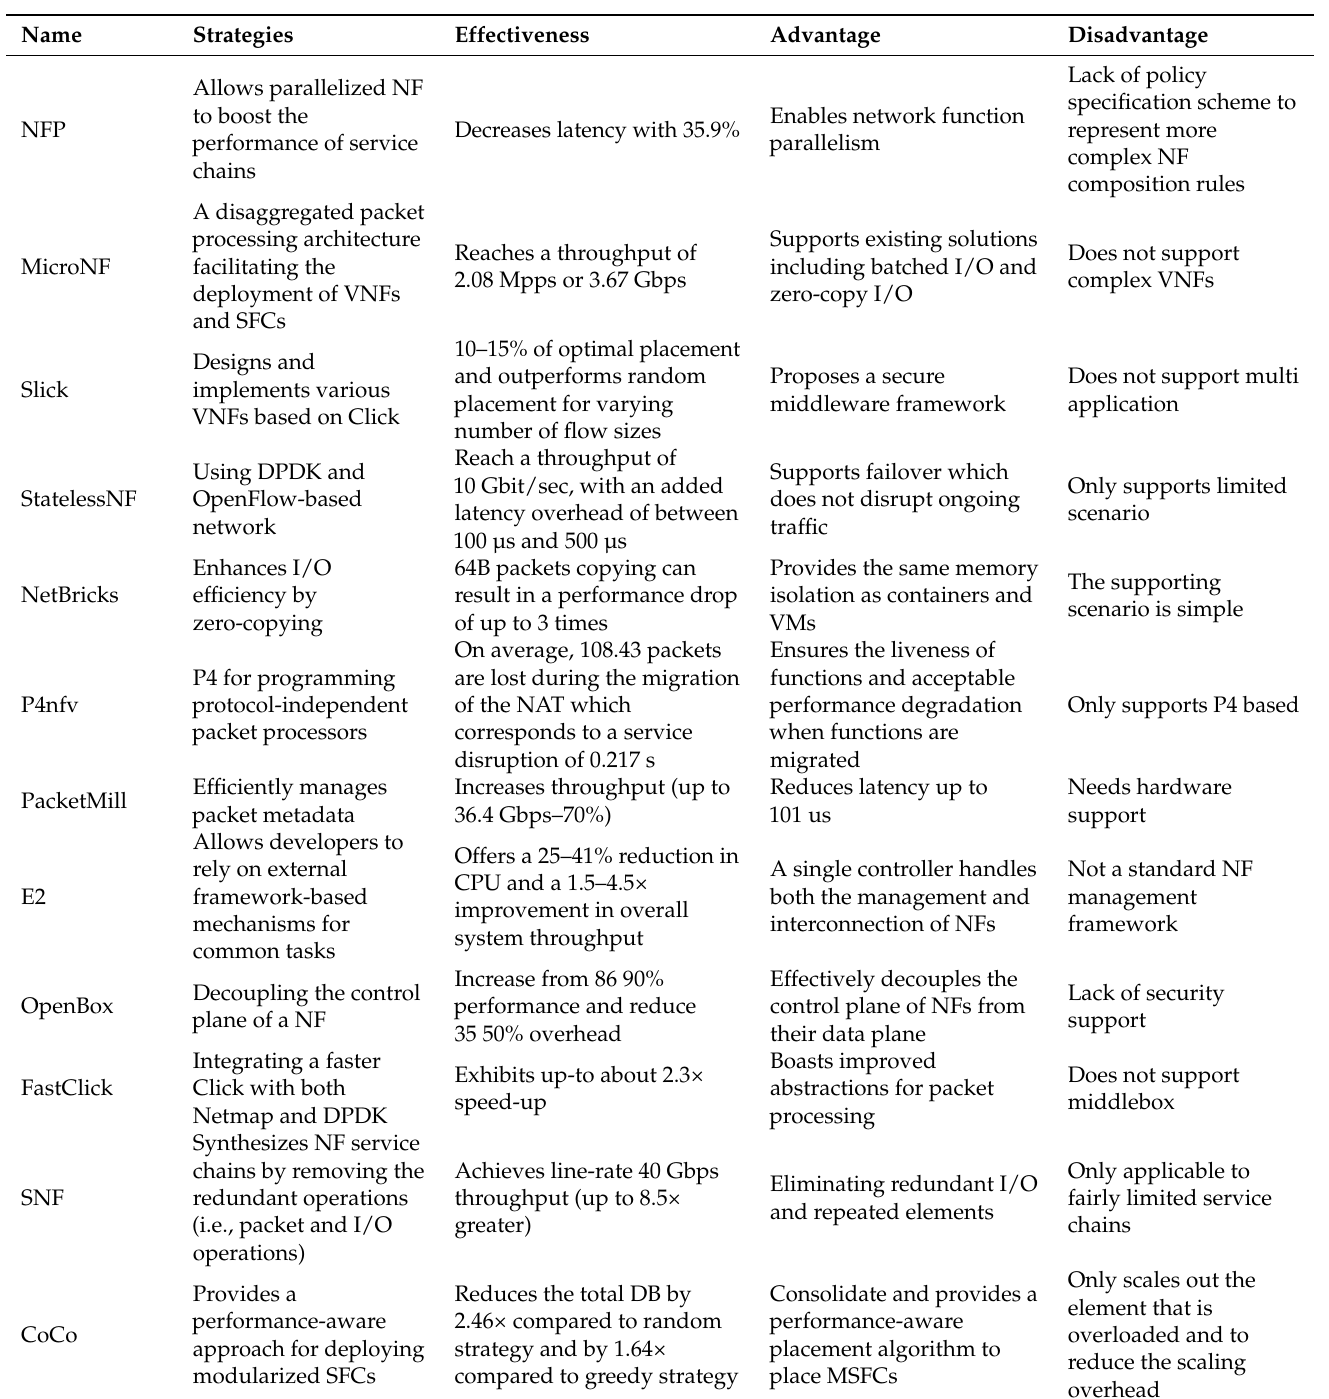
Table 2. The acceleration solutions in EMS by routing